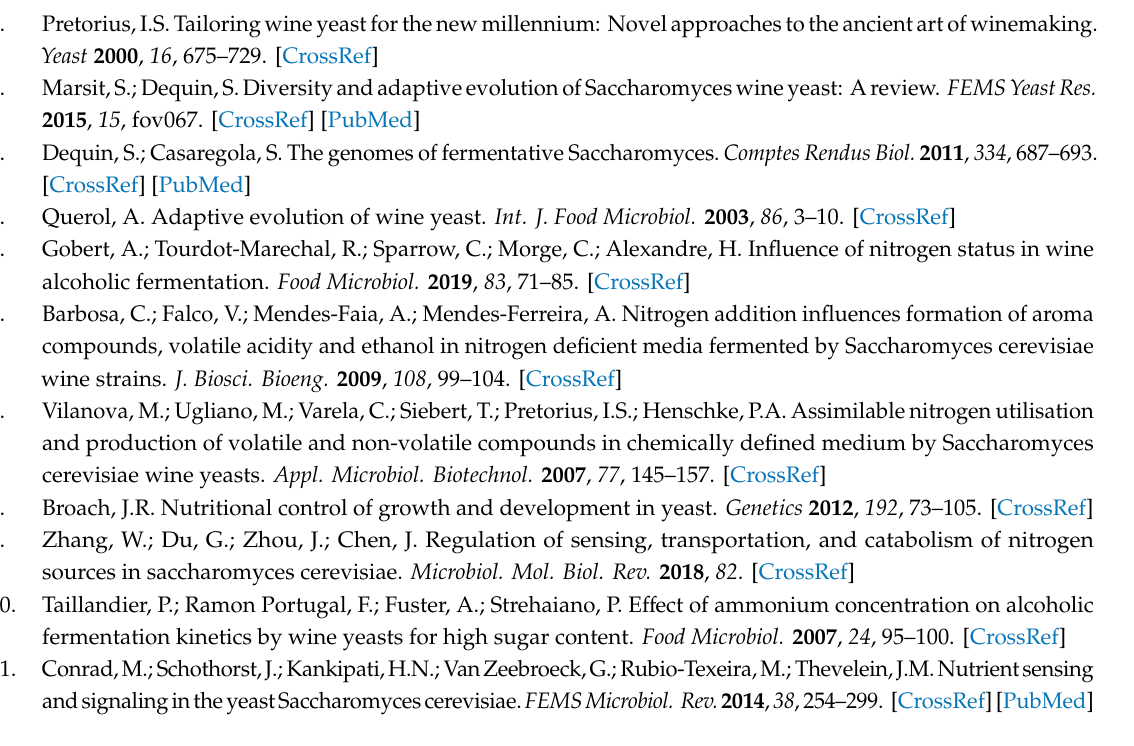
Table S1: Geographical origin of F 0 population, Table S2: Oenological parameters of F 1 population, Table S3: Statistical parameters for evaluated SSRs, Table S4: Oenological parameters of F 2 population, Table S5: YAN consumption of improved strain “476” and their F 1 and F 0 parental strains, Table S6: YAN consumption of improved strain “686” and their F 1 and F 0 parental strains, Table S7: Initial YAN composition of natural grape must, Table S8: Oenological parameters of improved strain “686” and commercial strain EC1118, Table S9: YAN consumption of improved strain “686” and commercial strain